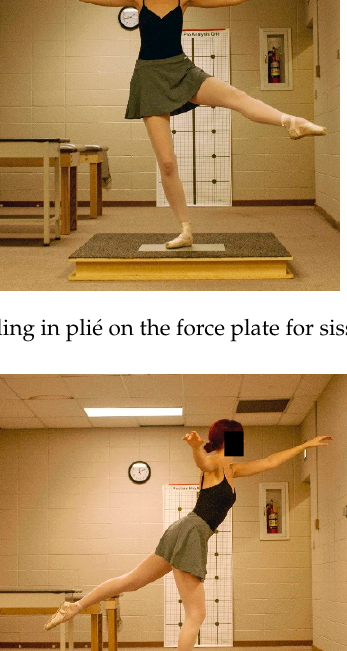
Figure 7. Jump landing in plié on the force plate for sauté arabesque.